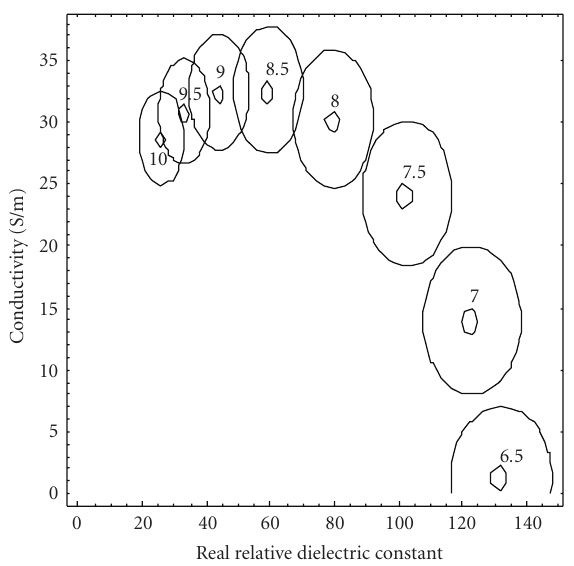
Figure 2: Exact complex dielectric values for bolus liquid with per- fect match, | Γ | = 0, and contours of constant reflection magnitude | Γ | = 0 . 03 for 6.5 to 10 GHz, in steps of 0.5 GHz.